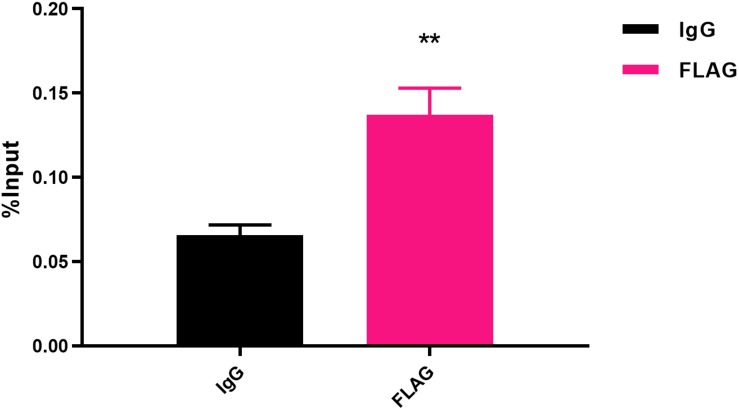
Fold enrichment of the flgI promoter in ChIP samples measured via ChIP-qPCR. The results show the promoter of flgI was extremely enriched in FlhF-ChIP samples, and the relative quantity was significantly higher than in the IgG control samples. Genome fragments isolated from wild-type flhF-FLAG strain were immunoprecipitated with corresponding antibodies, and analyzed by real-time PCR using primer sets corresponding to transcriptional start site regions of the flgI. For ChIP-qPCR experiments, the sample was cross-linked and sonicated to generate small DNA fragments, and then divided into three parts. The first was used as an input control. The second was incubated with normal rabbit IgG that will not bind to nuclear proteins to generate immuno-precipitated DNA (IgG). The third was as ChIP-FLAG immunoprecipitated sample (FLAG) (O’Geen et al., 2010). Results represent mean enrichment as measured by qPCR in at least three biological replicate experiments. Data are presented as mean ±SD. Data were analyzed by one-sample t-test (** P values are < 0.01, but > 0.001) to estimate the significance of fold change between FlhF-ChIP samples and IgG control samples.